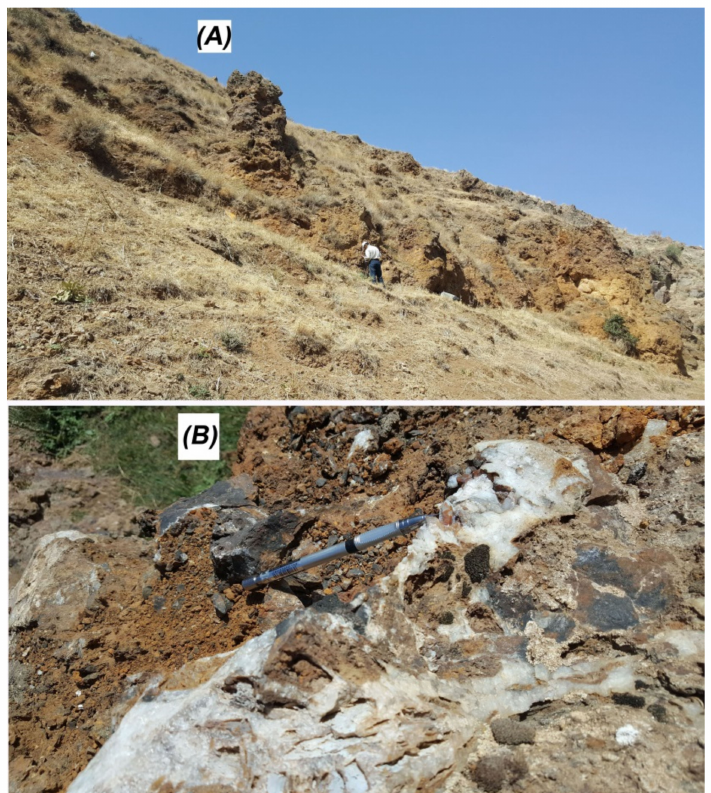
Figure 19. The iron oxides (limonitic-hematite rocks) in Javan-Sheikh area. ( A ) View of limonitic-hematite rocks; ( B ) View of oxidized breccia with banded chalcedonic quartz infill.